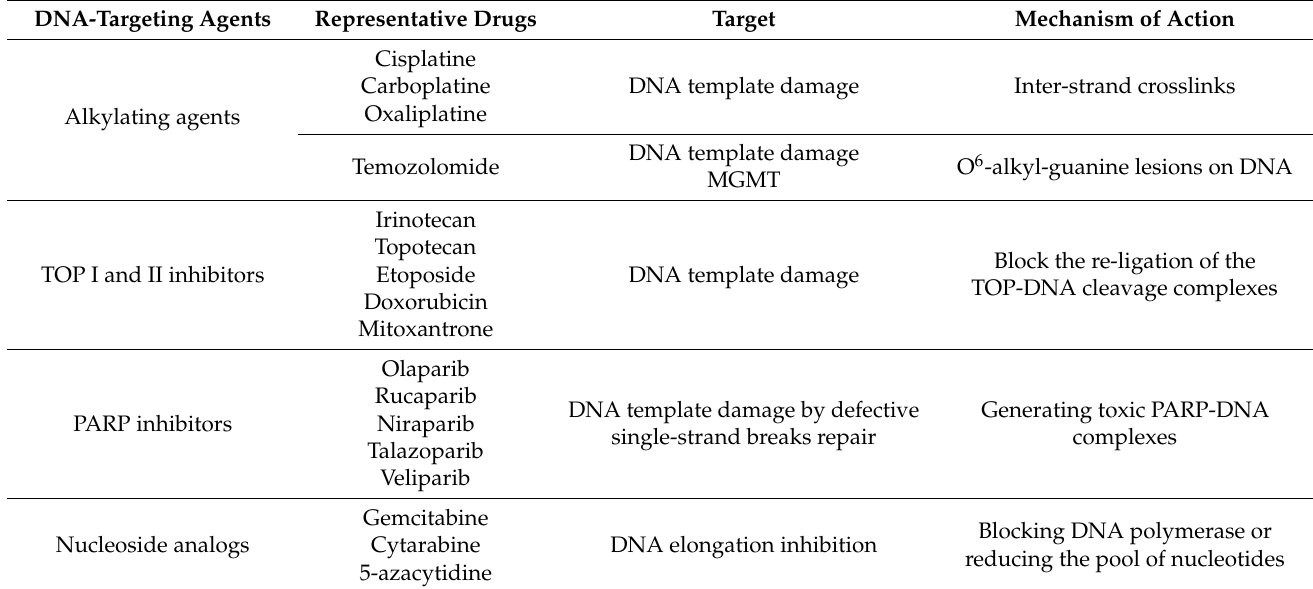
Table 1. Anticancer agents inducing replication stress (based on